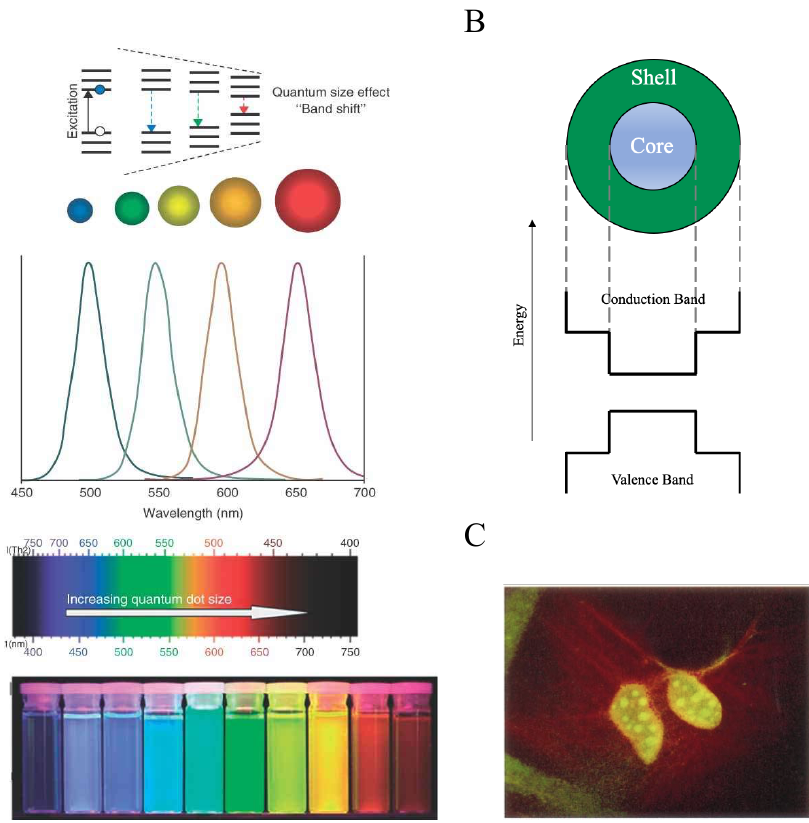
Figure 1. Properties of quantum dots. ( A ) Correlation between optical properties and the size of quantum dots. Reproduced with permission [5]; ( B ) Typical structure of quantum dots with a central core in which electrons occupy only discrete energy levels, and an insulator shell; ( C ) 3T3 mouse fibroblasts labeled with cadmium selenide/cadmium sulfide quantum dots (CdSe-CdS QDs) [12]. Reproduced with permission from American Association for the Advancement of Science.